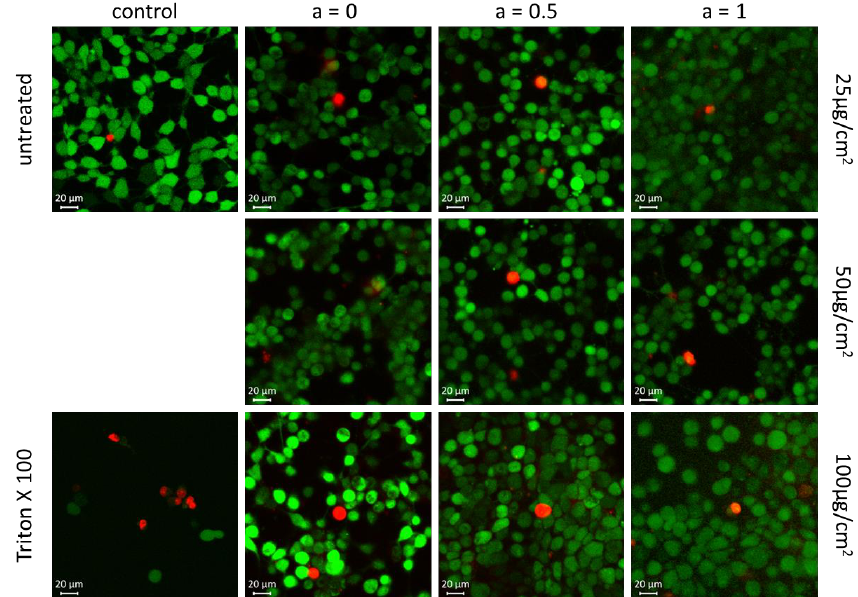
Figure 11. Vital fluorescent staining confirmed no reduced cell viability within 24 h for particles with an increasing Co content; the living cells and dead cells are colored in green and red, respectively. Magnification × 400.